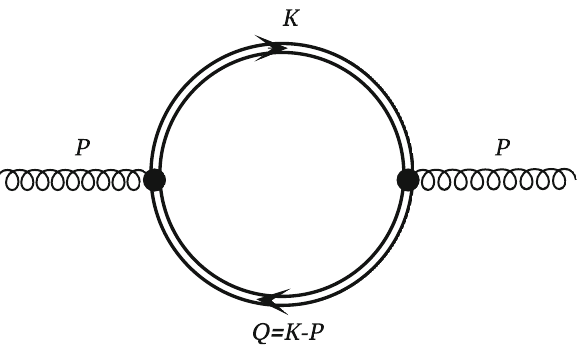
Fig. 2 Gluon polarization tensor in the limit of strong field approxi-